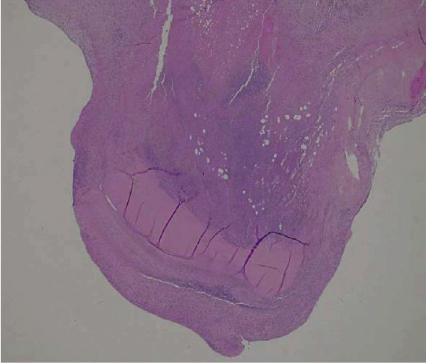
Figure 4: Anterior MV lea fl et: